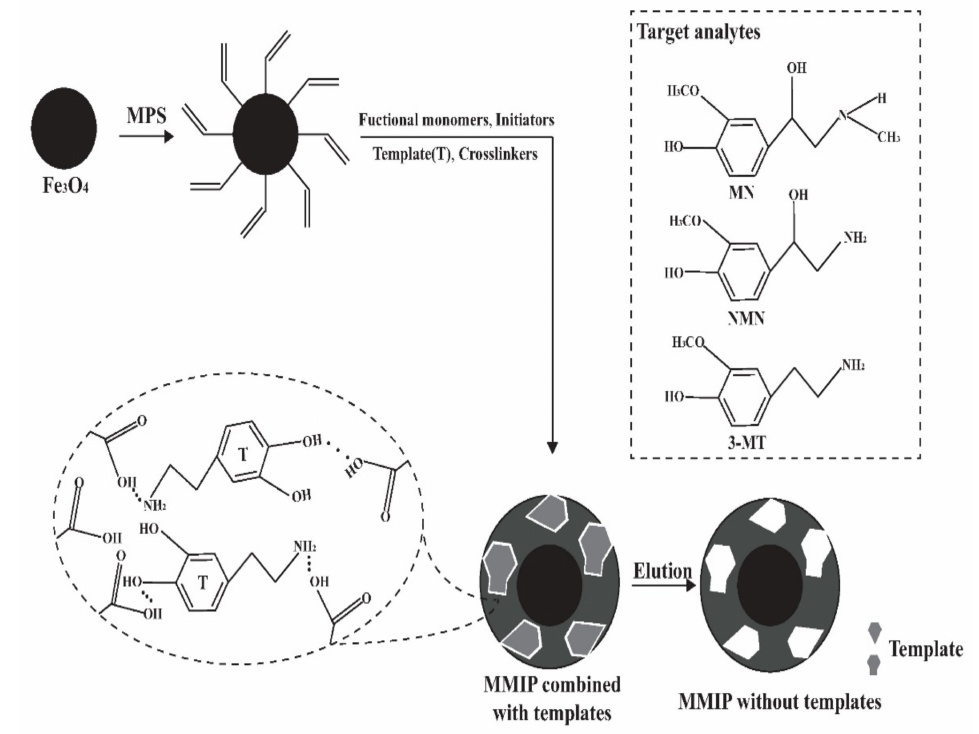
Figure 1. Schematic diagram of MMIP